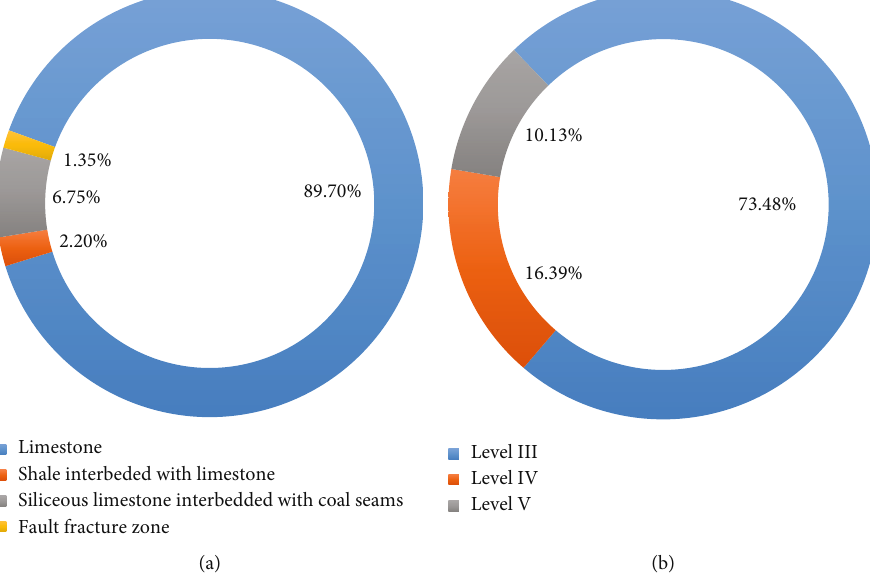
Figure 2: Lithology and surrounding rock level proportion: (a) lithology proportion; (b) surrounding rock level proportion.